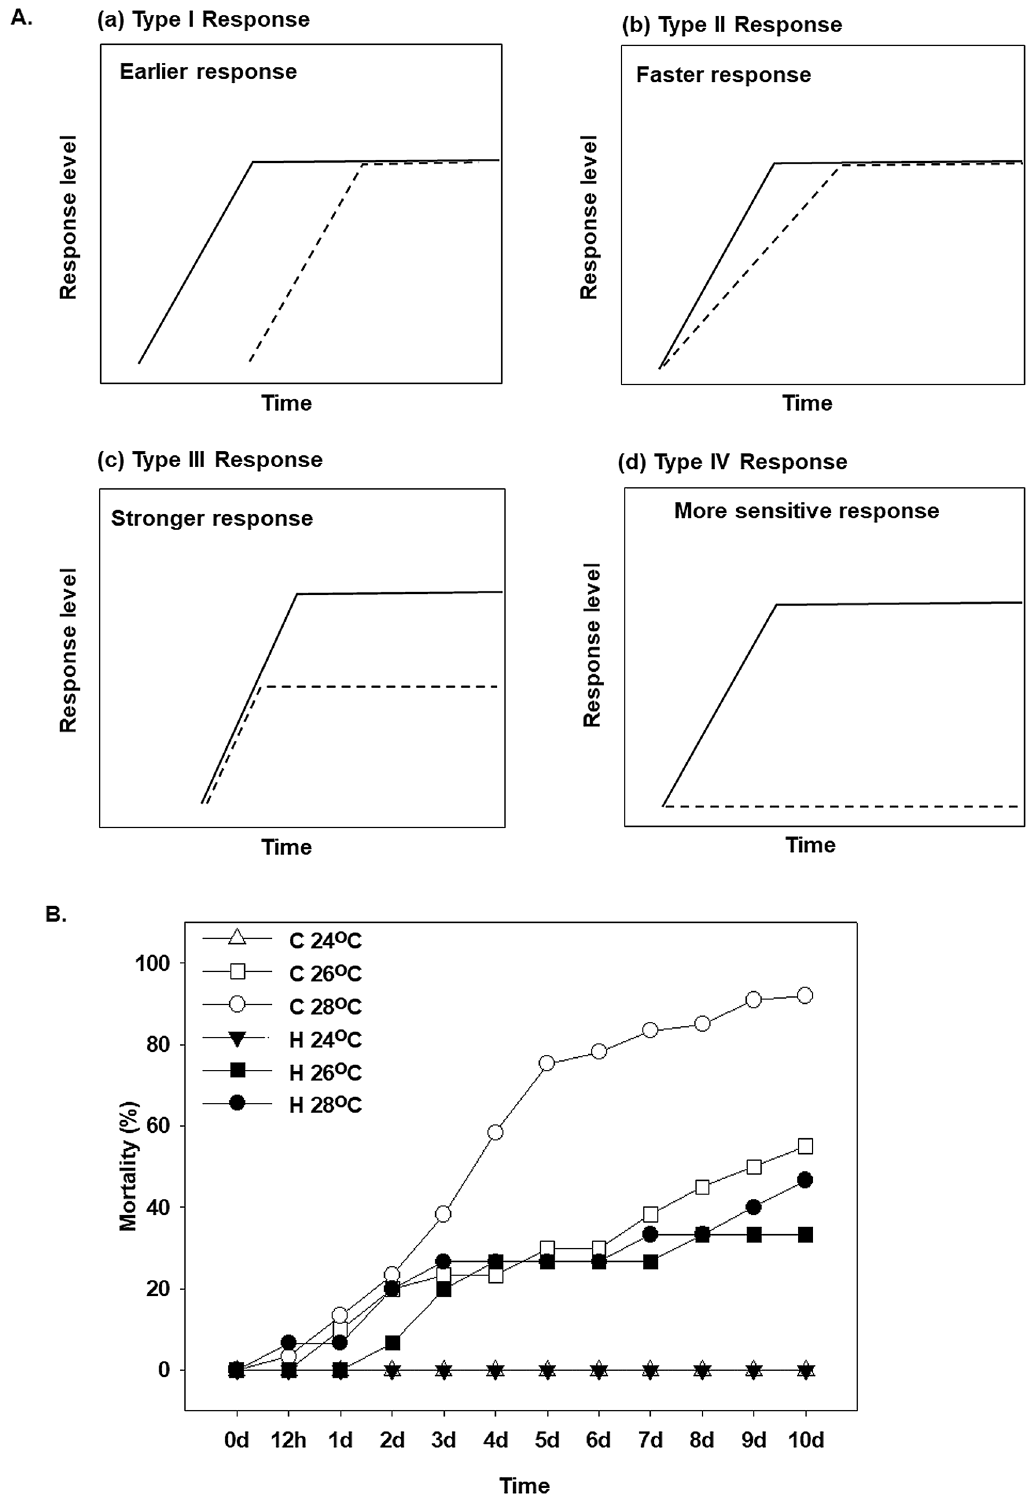
Figure 1. ( A ) Four main types of stress responses depending on the amplitude and the time course, involved in hardening have been described in Conrath et al. 28 and Hilker et al. 18 : (a) an earlier stress response (type I response), (b) a faster stress response (type II response), (c) a stronger stress response (type III response) and (d) a higher sensitivity hardening stress response (type IV response). Continuous lines indicate primed response to stress while dashed lines indicate non-primed response to stress. ( B ) Effect of water temperature (24, 26 and 28 °C) on the mortality of heat hardened (H) and non-hardened (C) Mytilus galloprovincialis compared to control at 18